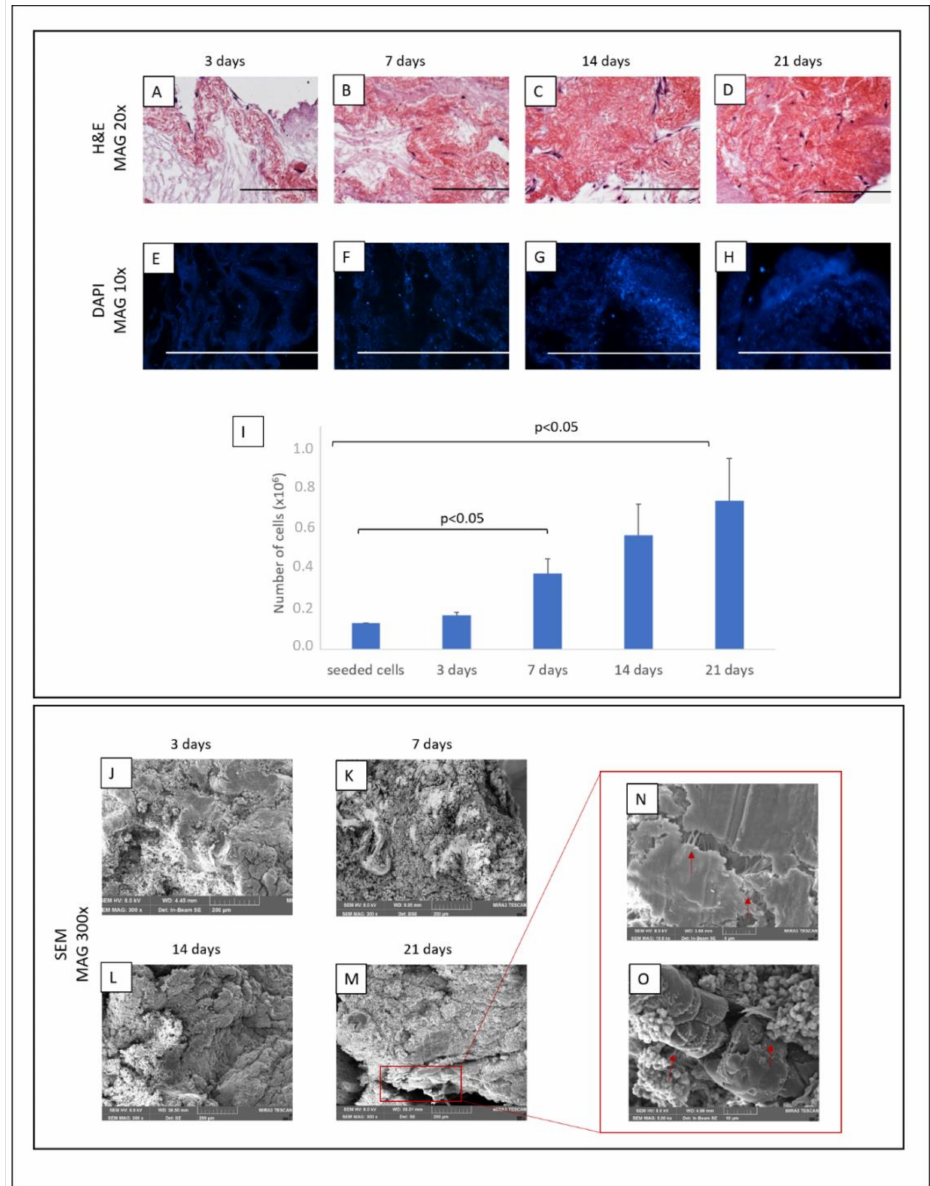
Figure 4. ECM scaffolds repopulated by pMSC. Upper panel: H&E ( A – D ) and DAPI ( E – H ) staining demonstrated that adherent cells increased progressively, reaching almost a complete scaffold cover- age (scale bar: 200 µ m for each). The viability of pMSCs seeded on scaffolds was confirmed by MTT assay ( I ). Lower panel ( J – O ): The degree of repopulation was also evaluated by SEM analysis. SEM images showed the formation of intracellular junctions and the development of a new extracellular matrix